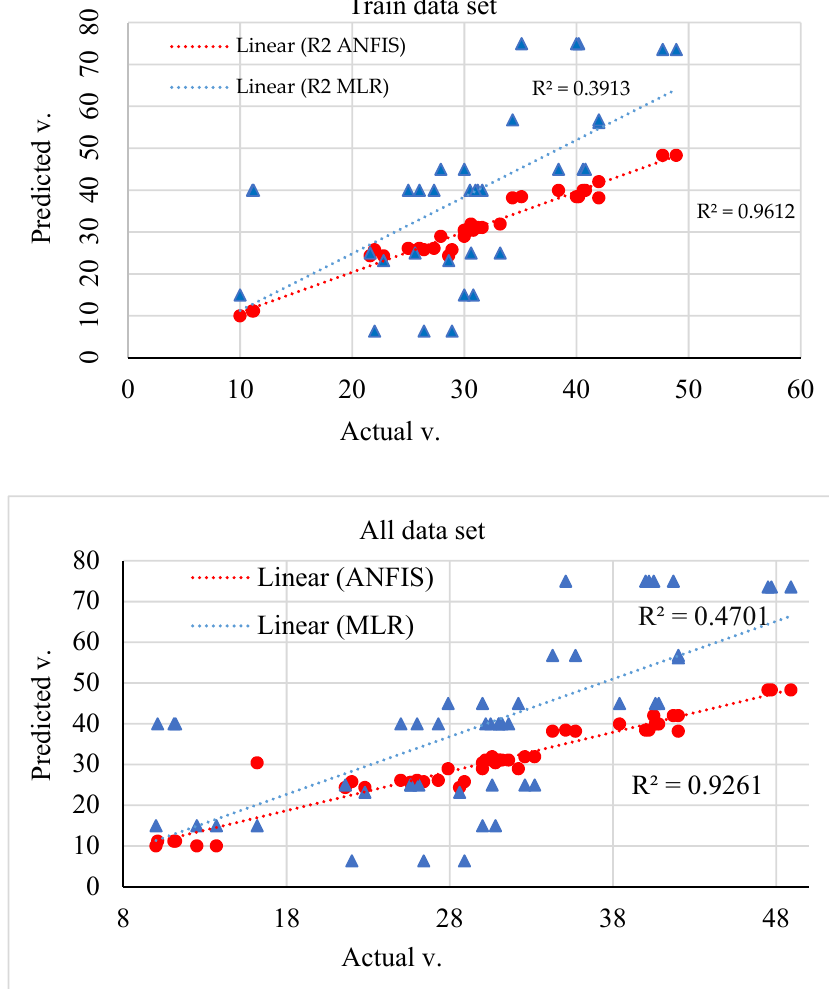
Figure 4. Correlation between the actual data of tensile index (MPa) and predicted ones by ANFIS and MLR models in both training and all data (blue triangles and red circles marks belong to MLR and ANFIS models, respectively).